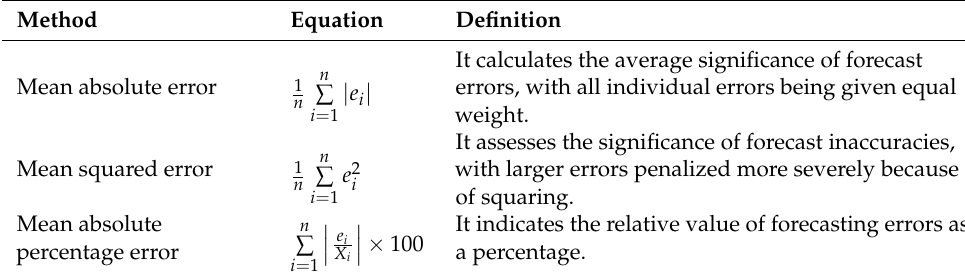
Table 5. The three evaluation methods of forecasting models performed